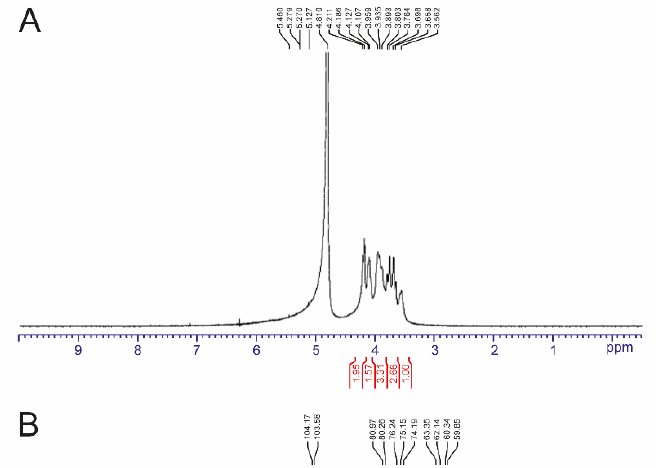
Figure 3. ( A ) 1 H-NMR and ( B ) 13 C-NMR spectrum of the polymer synthesized by wild-type LsKK9. Table 1. Comparison of the 13 C-NMR chemical shifts of the levan produced from di ff erent bacterial sources.